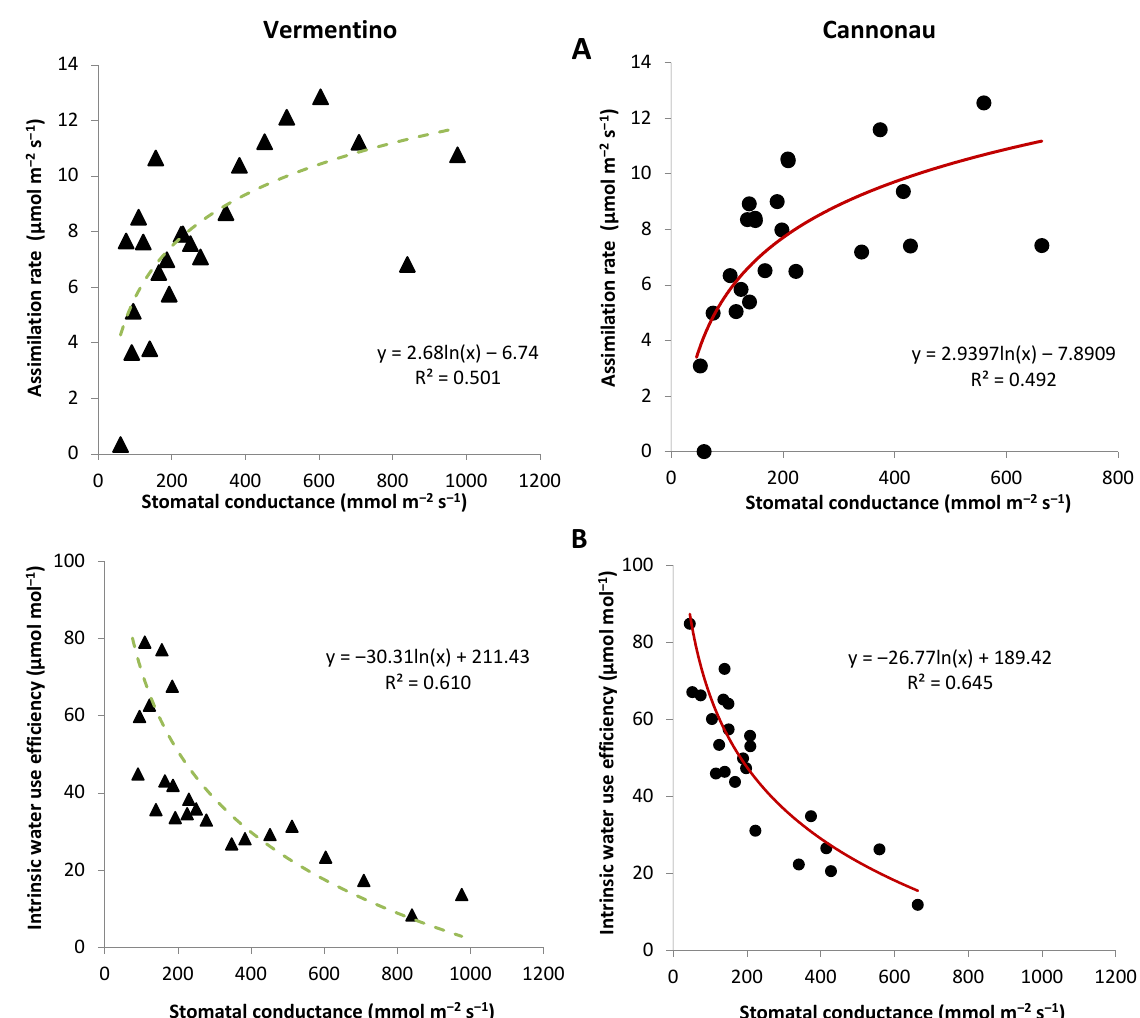
Figure 2. Correlations between observed midday net assimilation rate and stomatal conductance in Vermentino (green dashed line) and Cannonau (red solid line) leaves ( A ); and between leaf stomatal conductance and intrinsic water use efficiency ( B ), in the 3 sites.